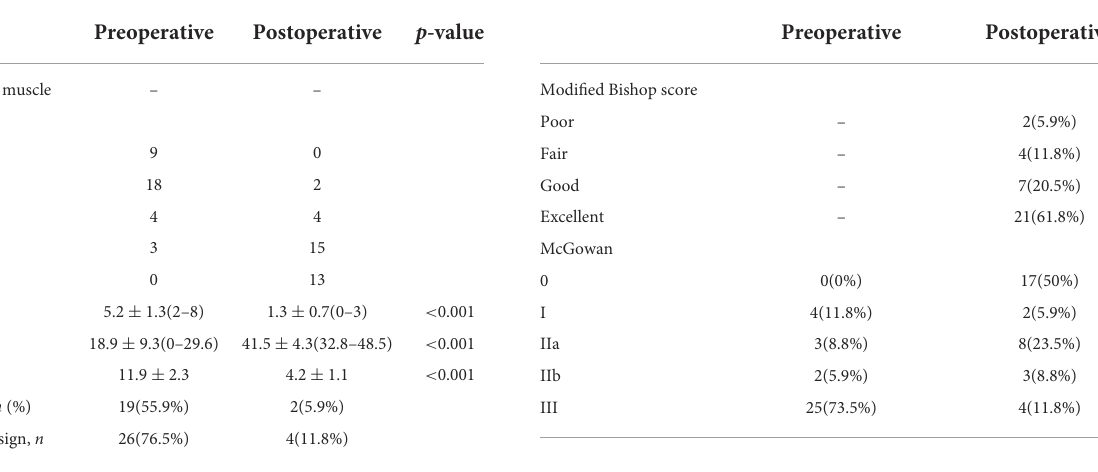
TABLE 2 Physical examination findings. TABLE 3 Preoperative and postoperative functional